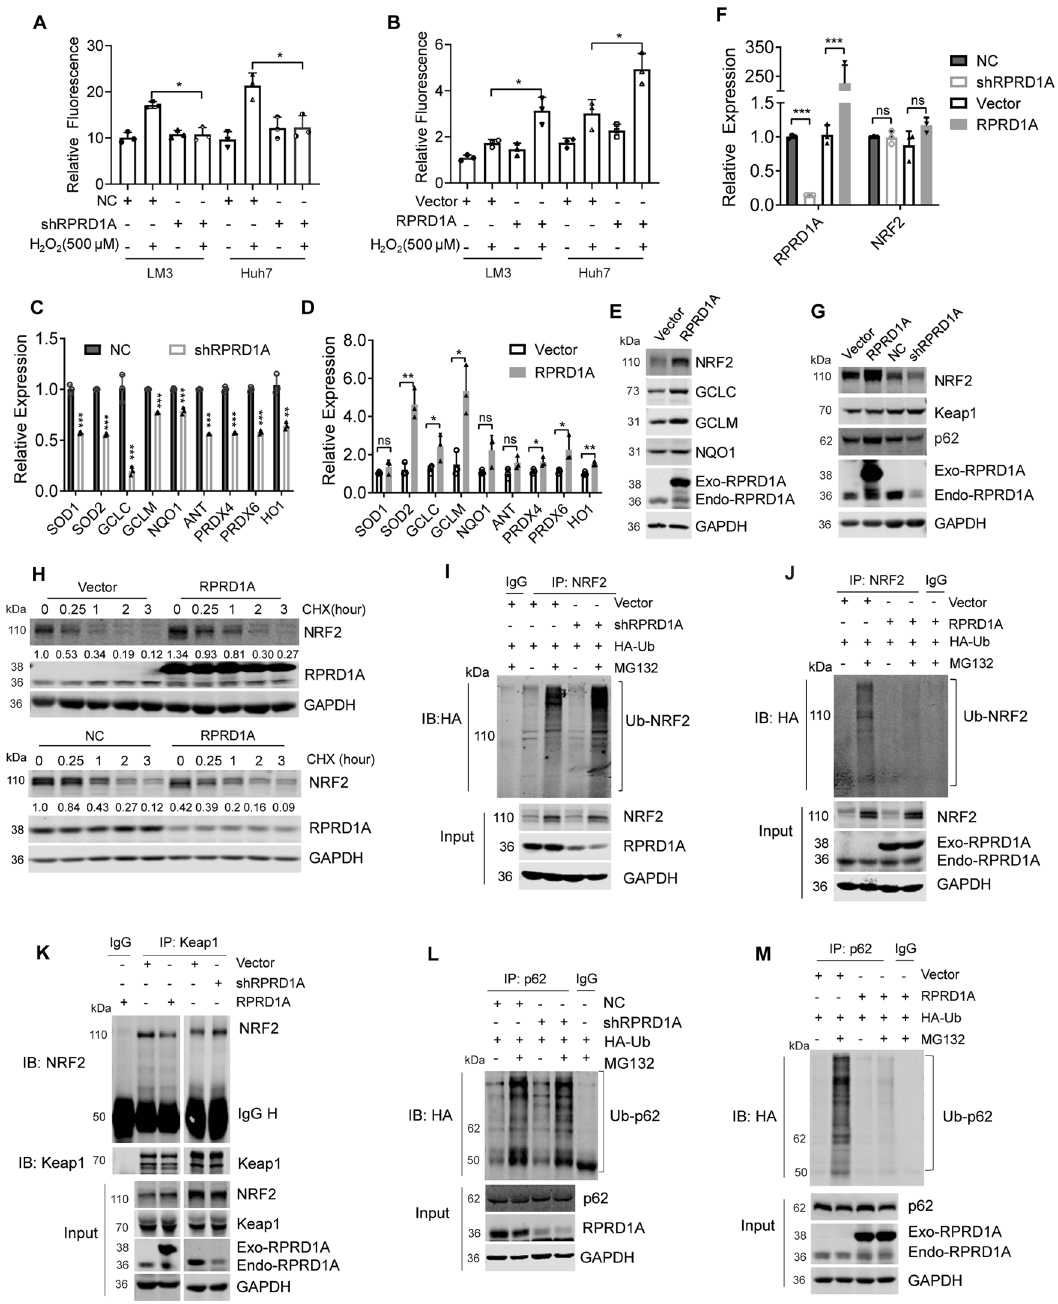
Fig. 4 RPRD1A inhibits ubiquitin-proteasome mediated degradation of NRF2. A , B ARE-luciferase reporter activity assay in MHCCLM3-NC, MHCCLM3-shRPRD1A, MHCCLM3-vector and MHCCLM3-RPRD1A ( A ), Huh7-NC, Huh7-shRPRD1A, Huh7-vector and Huh7-RPRD1A ( B ) cells. C , D RT-PCR analysis was performed for 18S, RPRD1A, SOD1, SOD2, GCLC, GCLM, NQO1, HO1, ANT, PRDX4, and PRDX6 in MHCCLM3-NC and MHCCLM3-shRPRD1A ( C ), MHCCLM3-vector and MHCCLM3-RPRD1A ( D ) cells. E Western blotting analysis showed the levels of NRF2, GCLC, GCLM, NQO1, RPRD1A, and GAPDH in control and RPRD1A overexpressed MHCCLM3 cells. F RT-PCR analysis was performed to detect the expression of NRF2 in MHCCLM3-NC, MHCCLM3-shRPRD1A, MHCCLM3-vector and MHCCLM3-RPRD1A cells. G Western blotting analysis showed the levels of NRF2, Keap1, p62, RPRD1A, and GAPDH in MHCCLM3-NC, MHCCLM3-shRPRD1A, MHCCLM3-vector and MHCCLM3- RPRD1A cells. H Western blotting and quanti fi cation of NRF2 expression in lysates from MHCCLM3 cells treated with 25 μ M cycloheximide for the indicated time with differentially expressed RPRD1A . I , J Ubiquitination levels of NRF2 were detected by immunoprecipitation and western blotting in MHCCLM3-NC and MHCCLM3-shRPRD1A ( I ), MHCCLM3-vector and MHCCLM3-RPRD1A ( J ) cells transfected with pcDNA3.1-HA-Ub plasmid and treated with 10 μ M MG132 for 12 h. K Immunoprecipitation analysis to detect the binding amount of Keap1 and NRF2 under the condition of RPRD1A knockdown or overexpression. Lysates were incubated with Keap1 antibody or control immunoglobulin G and protein A&G magnetic beads overnight; western blotting was used to detect the expression of NRF2 and Keap1. L , M Ubiquitination levels of p62 were detected by immunoprecipitation and western blotting in MHCCLM3-NC and MHCCLM3-shRPRD1A ( L ), MHCCLM3-vector and MHCCLM3- RPRD1A ( M ) cells transfected with pcDNA3.1- HA-Ub plasmid and treated with 10 μ M MG132 for 12 h. The p values were determined by a two- tailed t-test. * p < 0.05, ** p < 0.01, *** p < 0.001, ns, not signi fi cant. Results are representative of at least three independent experiments.